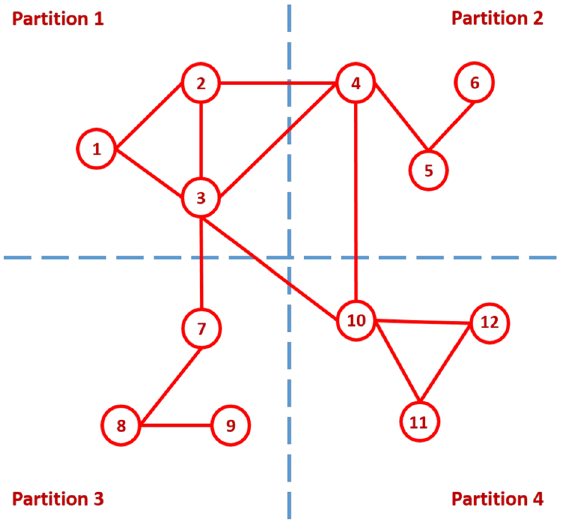
Figure 2. Graph input and partition example, ρ = 4 .